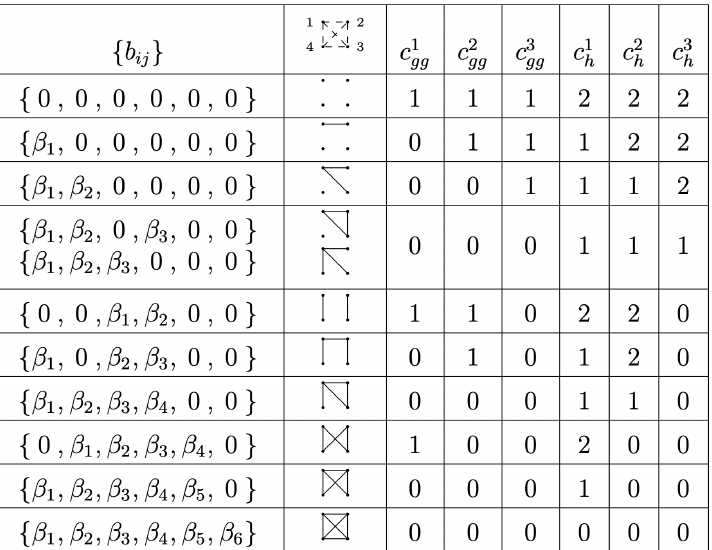
Table 1 . The full set of two-loop integrands F b R -charge structures. The coefficients enter eq. (2.20). All values β i ≥ 1 are equivalent due to the saturation